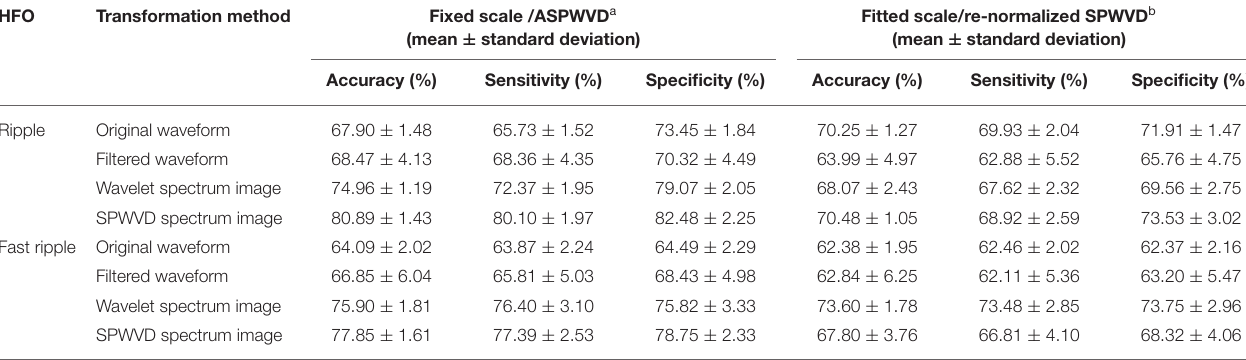
TABLE 2 | Performance of convolutional neural networks (CNNs) trained using various electroencephalogram (EEG) data transformations. HFO Transformation method